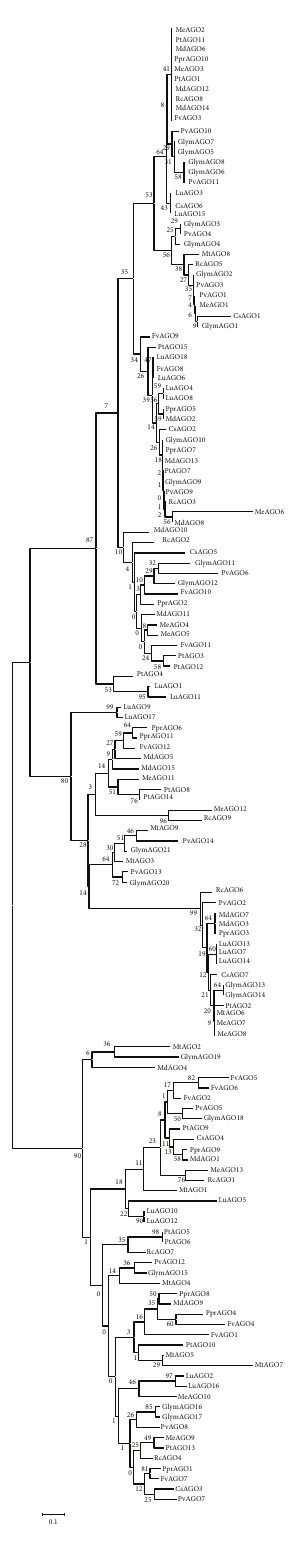
Figure 1: Phylogenetic tree of the Argonaute protein related to the Fabidae groups which consist of Manihot esculenta, Ricinus communis, Linum usitatissimum, Populus trichocarpa, Medicago truncatula, Phaseolus vulgaris, Glycine max, Cucumis sativus, Prunus persica, Malus domestica, and Fragaria vesca